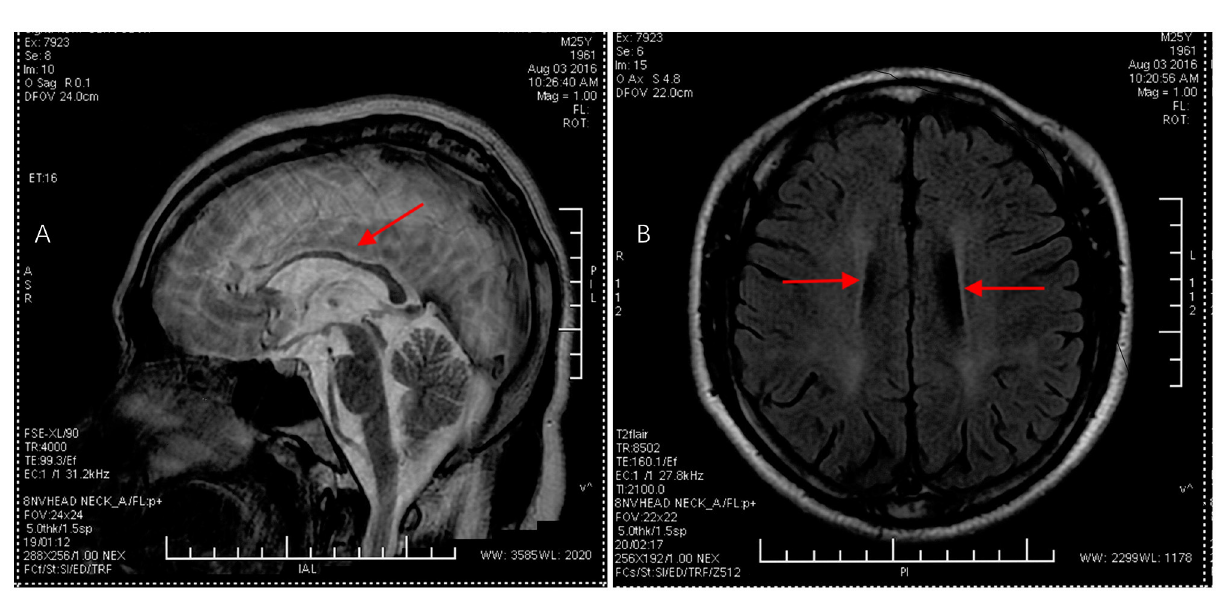
FIGURE1 Brain MRI images in the proband. (A) Sagittal T2-weighted image displayed thinning of the corpus callosum, as indicated by the red arrow. (B) Axial T1-weighted image showed symmetrical periventricular white matter lesions, as indicated by the red arrow.